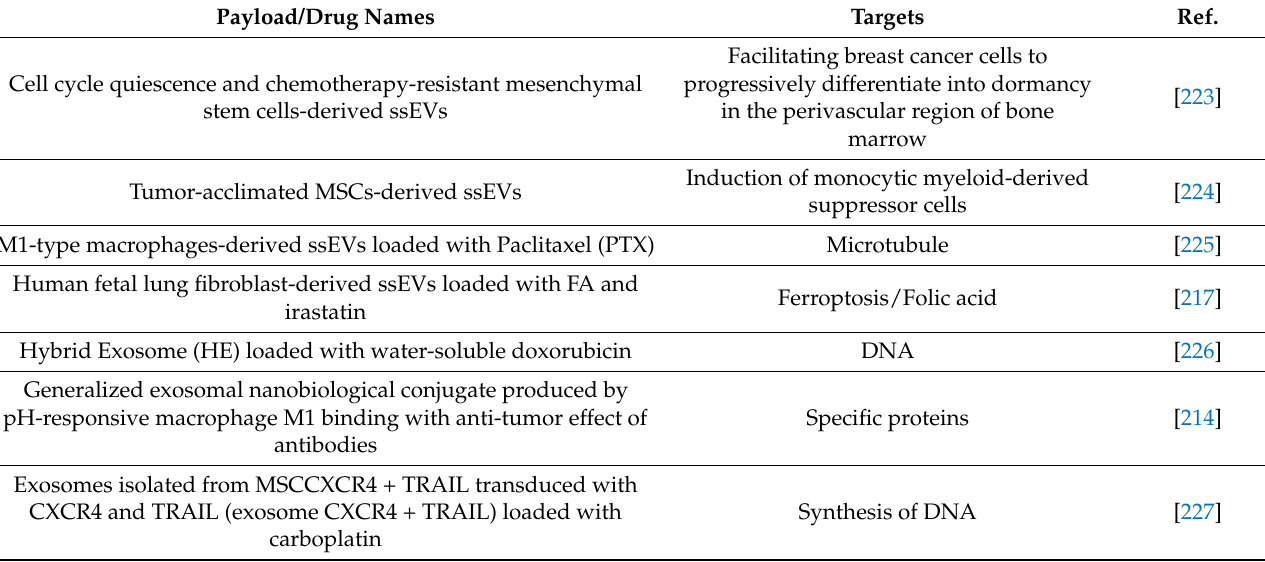
Table 3. Possible application of sEVs to breast cancer